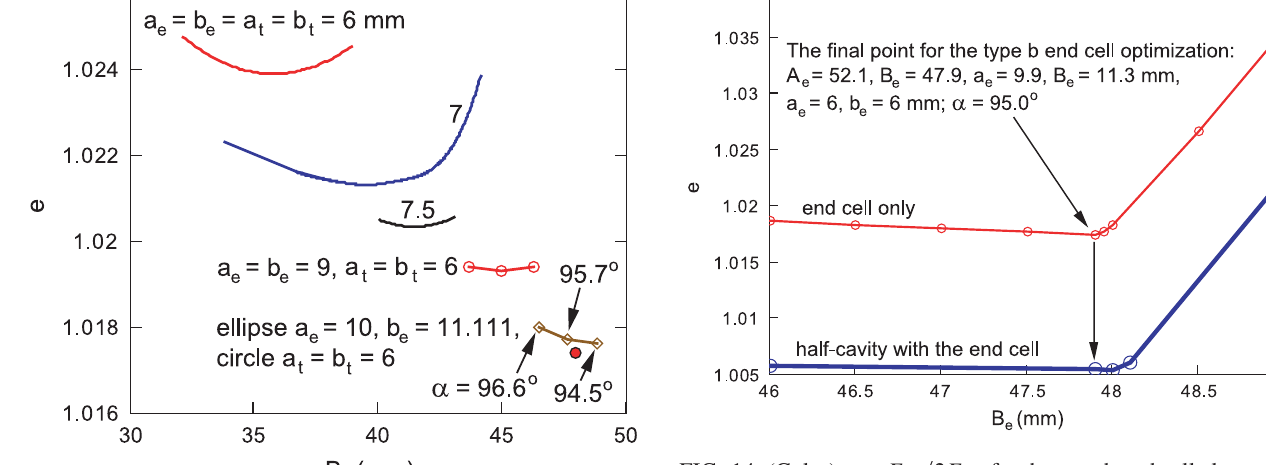
FIG. 14. (Color) e ¼ E for the half-cavity from Fig. 13.